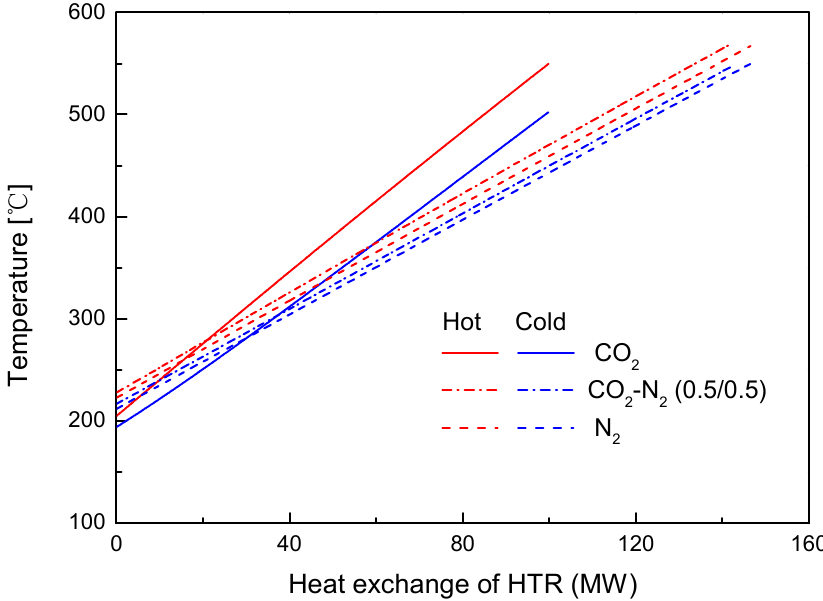
Figure 14. Temperature distributions of CO 2 - N 2 in HTR.